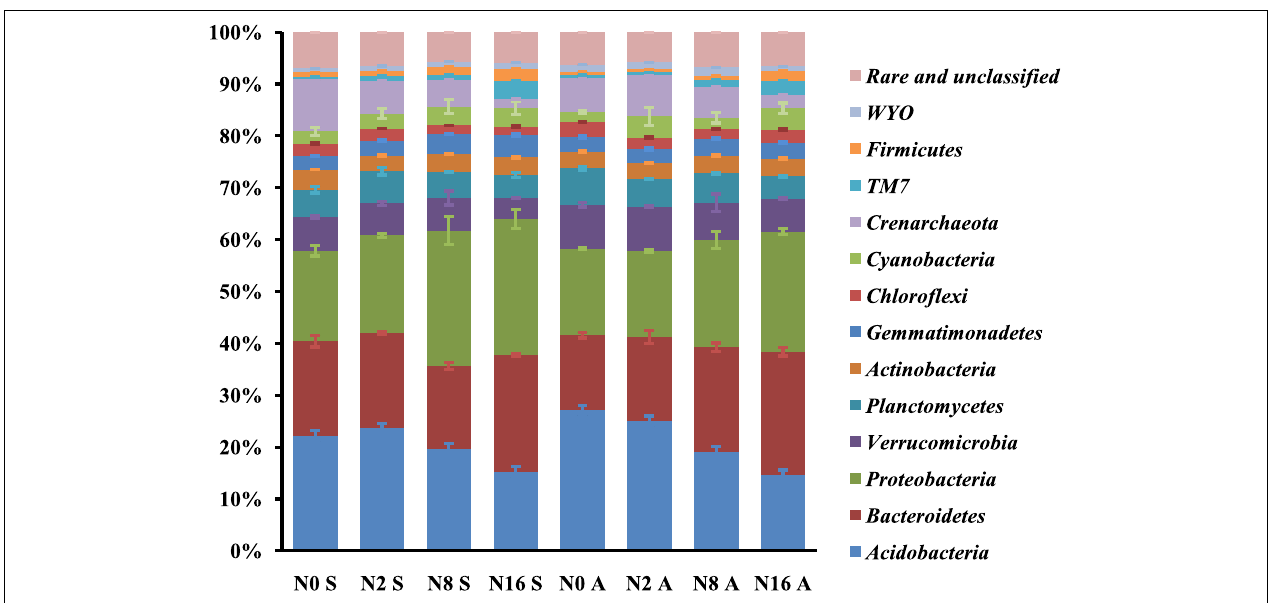
FIGURE 5 | The relative abundance of phyla of S. krylovii and A. frigida rhizosphere microbiome across all the N-supplied plots (% of total